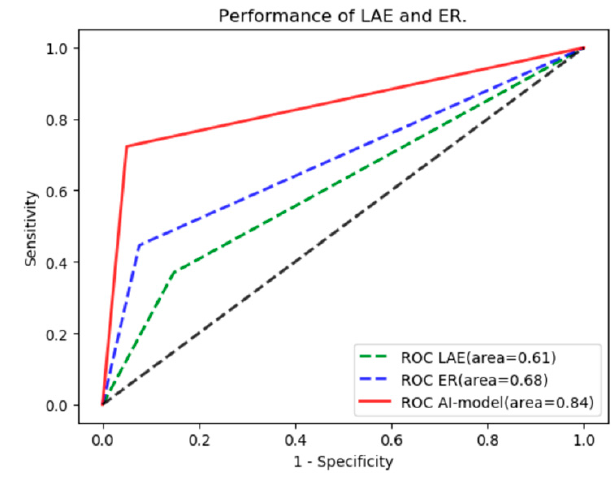
Figure 5. The Predictive Performance of Prognostic Factors. Table 3. The Confusion Matrix of Prognostic Factors.